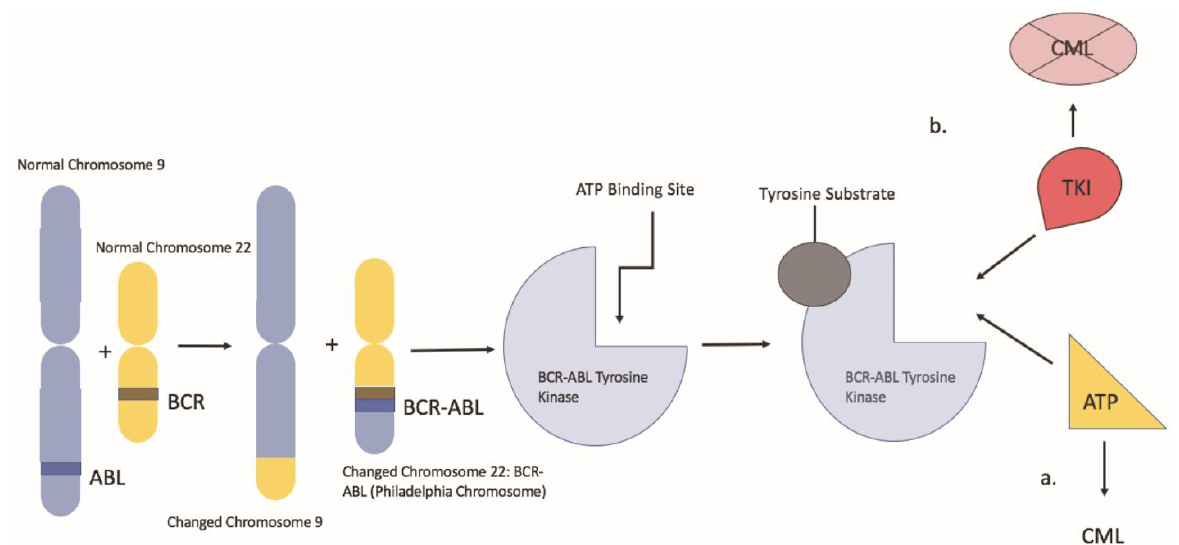
Figure 1. Represents a depiction of the Philadelphia chromosome balanced translocation and its mechanism of action. a: the BCR-ABL oncoprotein with a molecule of adenosine triphosphate (ATP) in the kinase pocket. The substrate is activated by the phosphorylation of tyrosine residues and can activate other down- stream pathways. b: w hen TKI occupies the kinase pocket, the action of BCR-ABL is inhibited, preventing phosphorylation of its